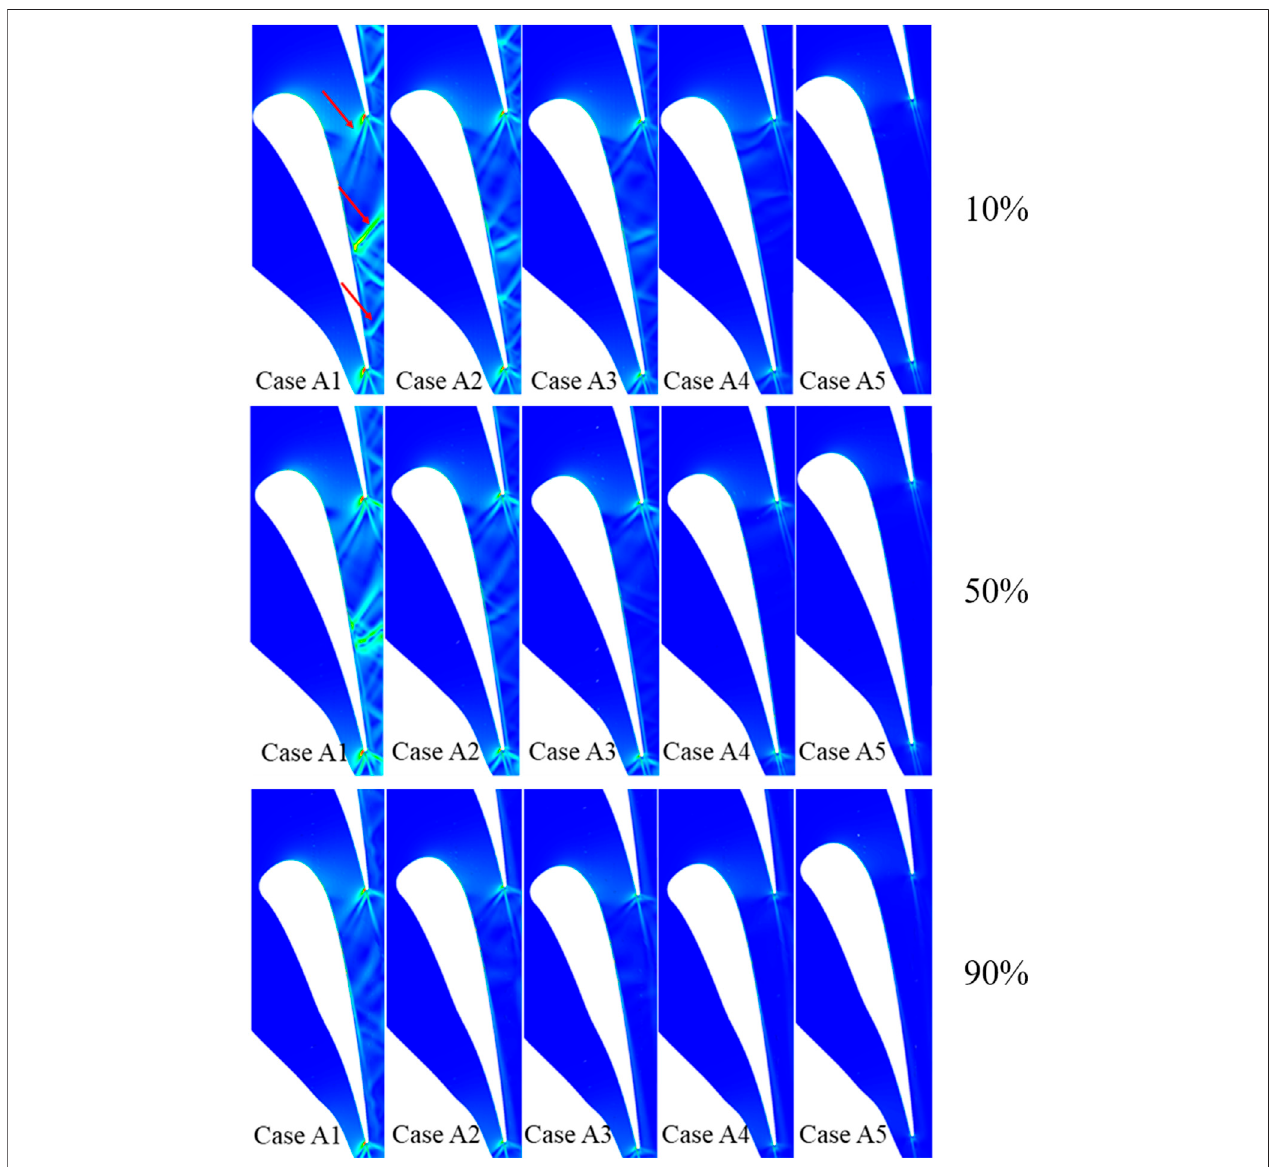
FIGURE 8 | Density gradient distribution of stators from Case A1 to Case